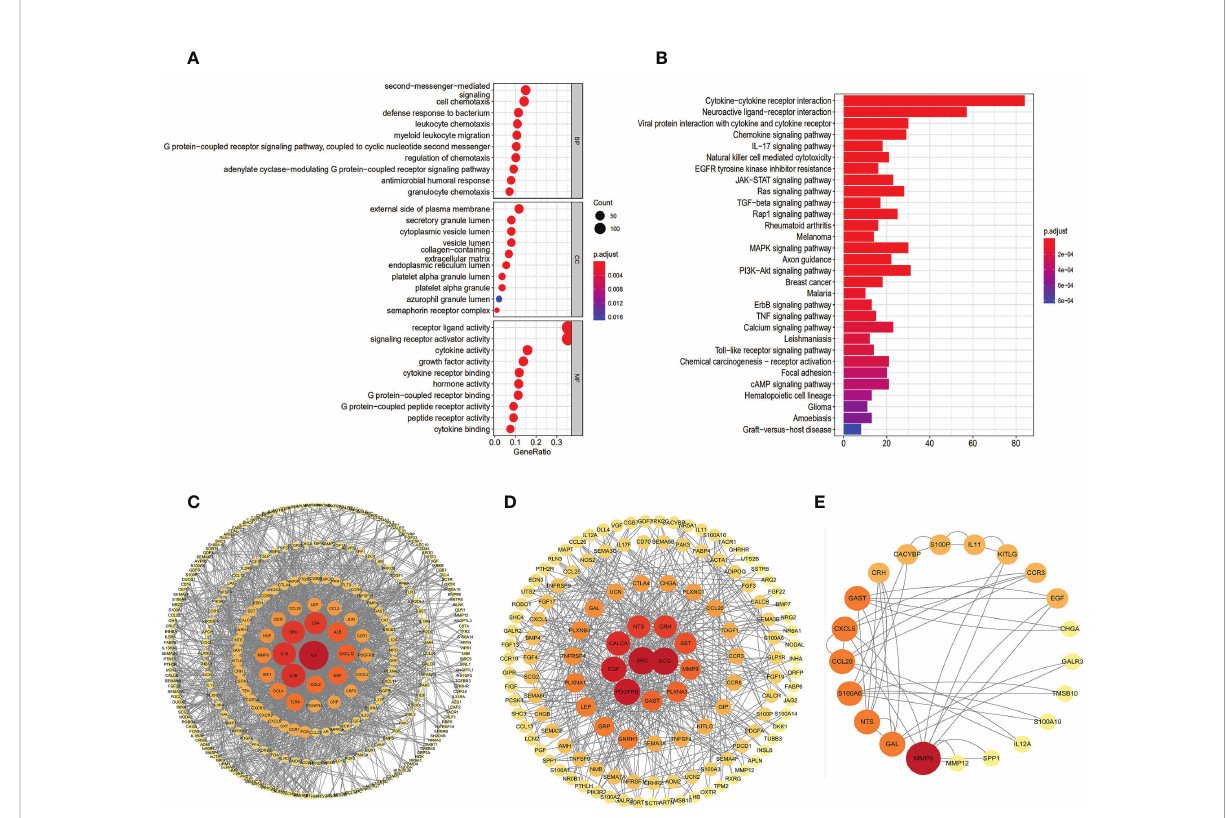
FIGURE 2 Gene functional enrichment analysis of differentially expressed IRGs. (A) The top 30 signi fi cant terms of GO function enrichment. BP biological process, CC cellular component, MF molecular function. (B) The top 30 signi fi cant terms of KEGG analysis.Protein – protein interaction network based on IRGs: all 401 DEIRGs (C) , 237 up-regulated IRGs (D) , 63 IRGs related to OS (E)